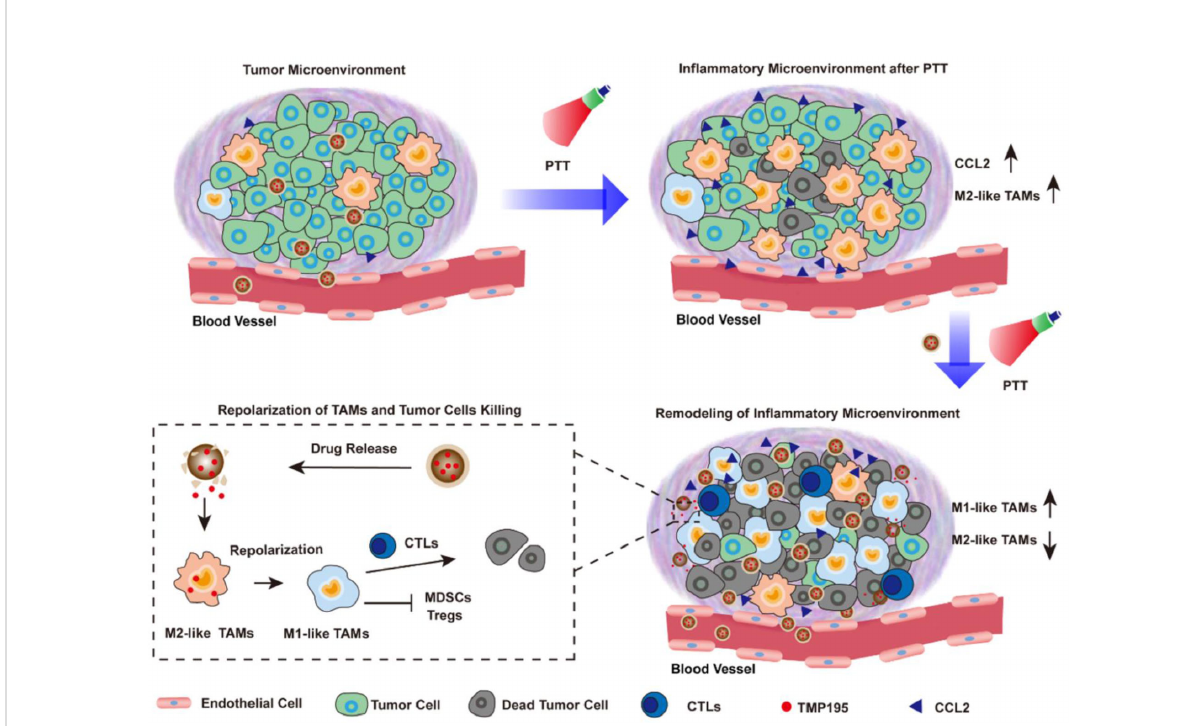
FIGURE 4 Nanoparticles incorporating HDAC inhibitor TMP195 was used for post-photothermal therapy to reeducate M2-like TAMs in the TME for better prognostics, reproduced from ref